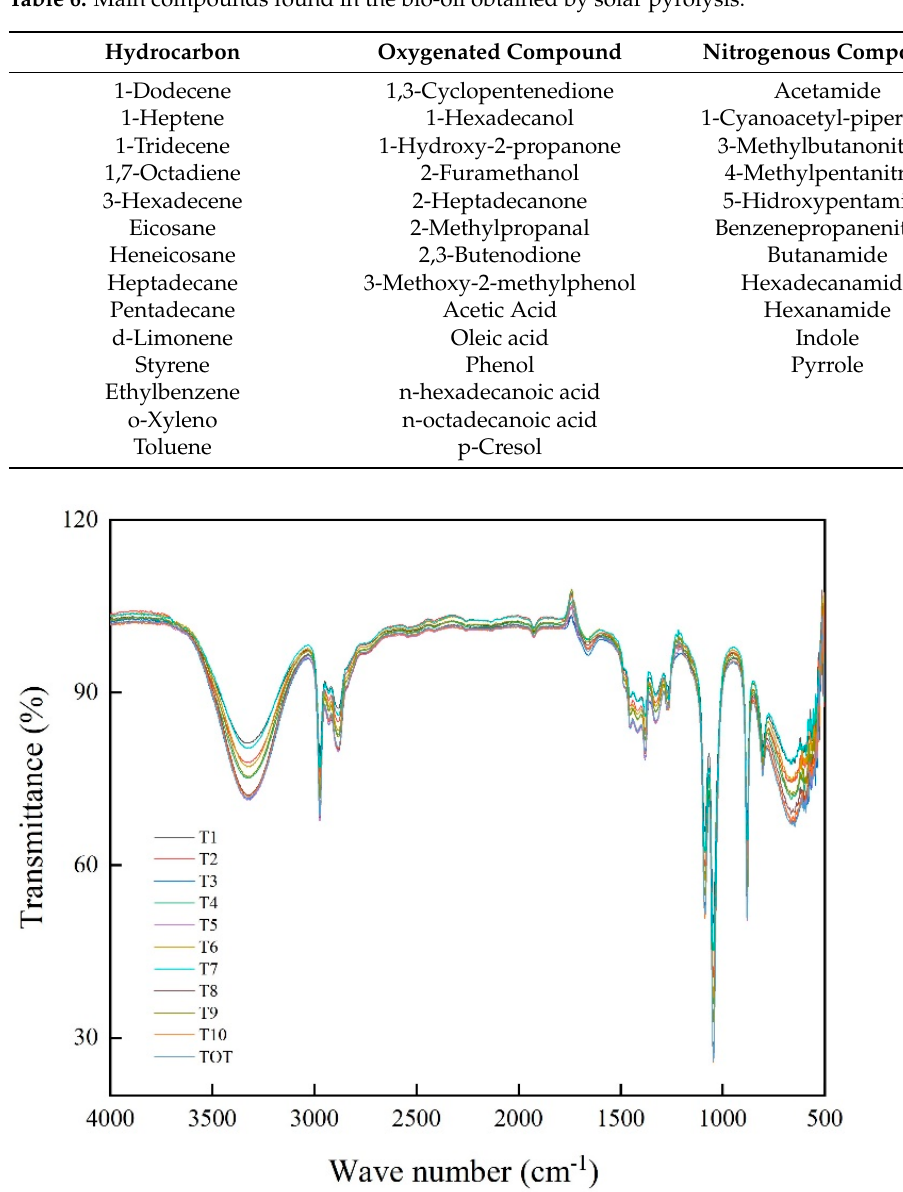
Figure 7. Infrared spectra of the bio-oil obtained by solar pyrolysis of Spirulina platensis. Table 6. Main compounds found in the bio-oil obtained by solar pyrolysis.